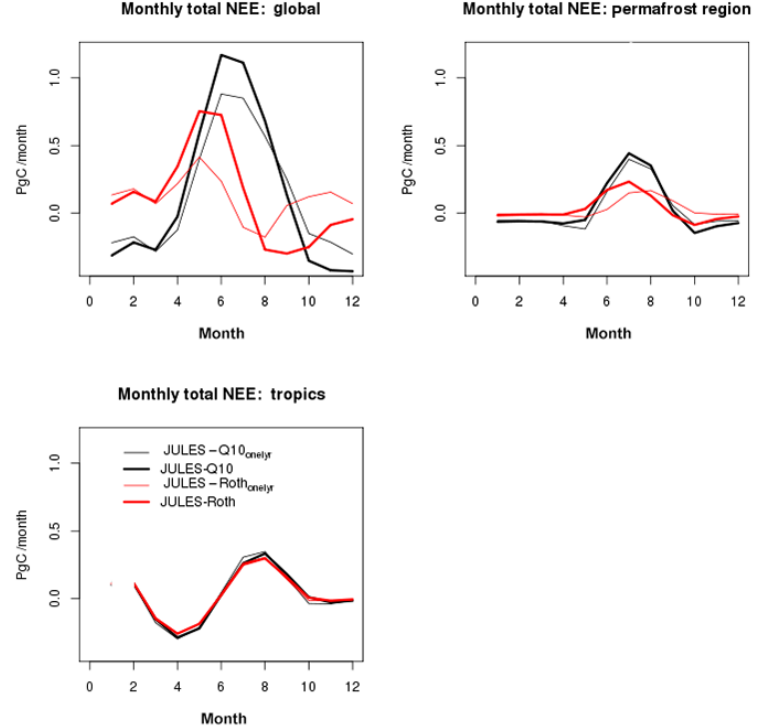
Figure 9. Seasonal cycle of net ecosystem exchange (NEE) for the three main regions considered in this paper. Positive values represent an uptake of carbon and negative values represent a loss of carbon.